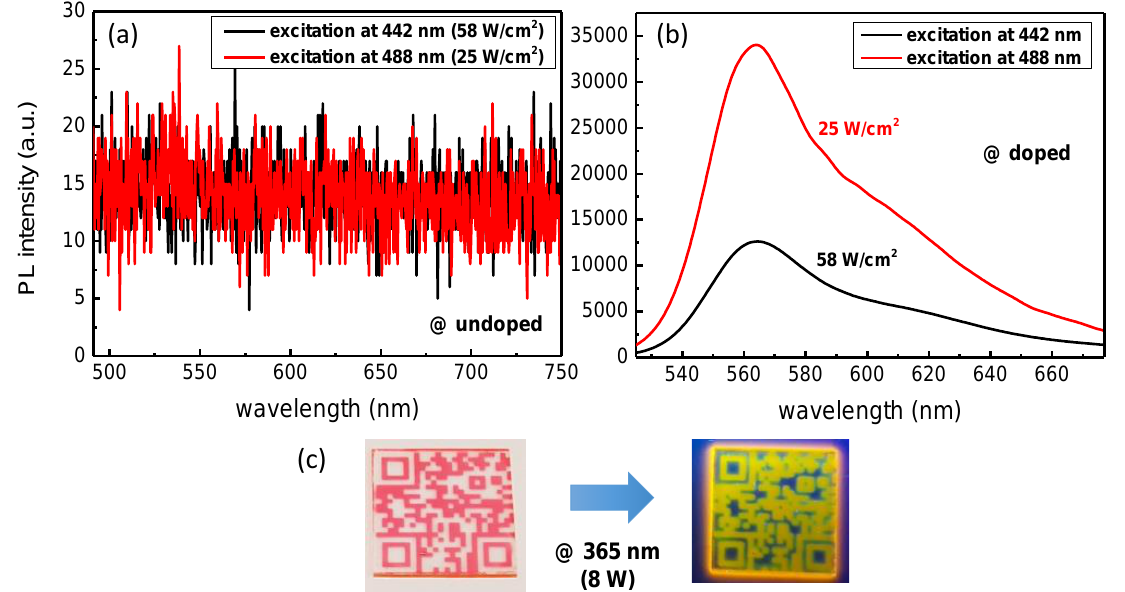
Figure 4. PL study under excitation at 442 nm and 488 nm for an undoped TiO 2 -SiO 2 sol-gel film ( a ) and a R6G doped sol-gel layer ( b ). A visual observation of the PL is given under excitation of a QR-code architecture (25 × 25 mm 2 ) at 365 nm ( c ).